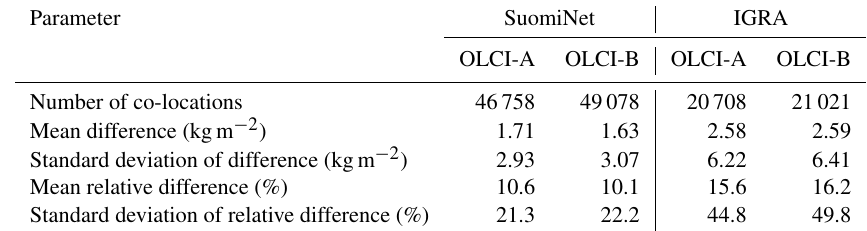
Table 1. Statistics of general comparisons shown in Fig. 2.